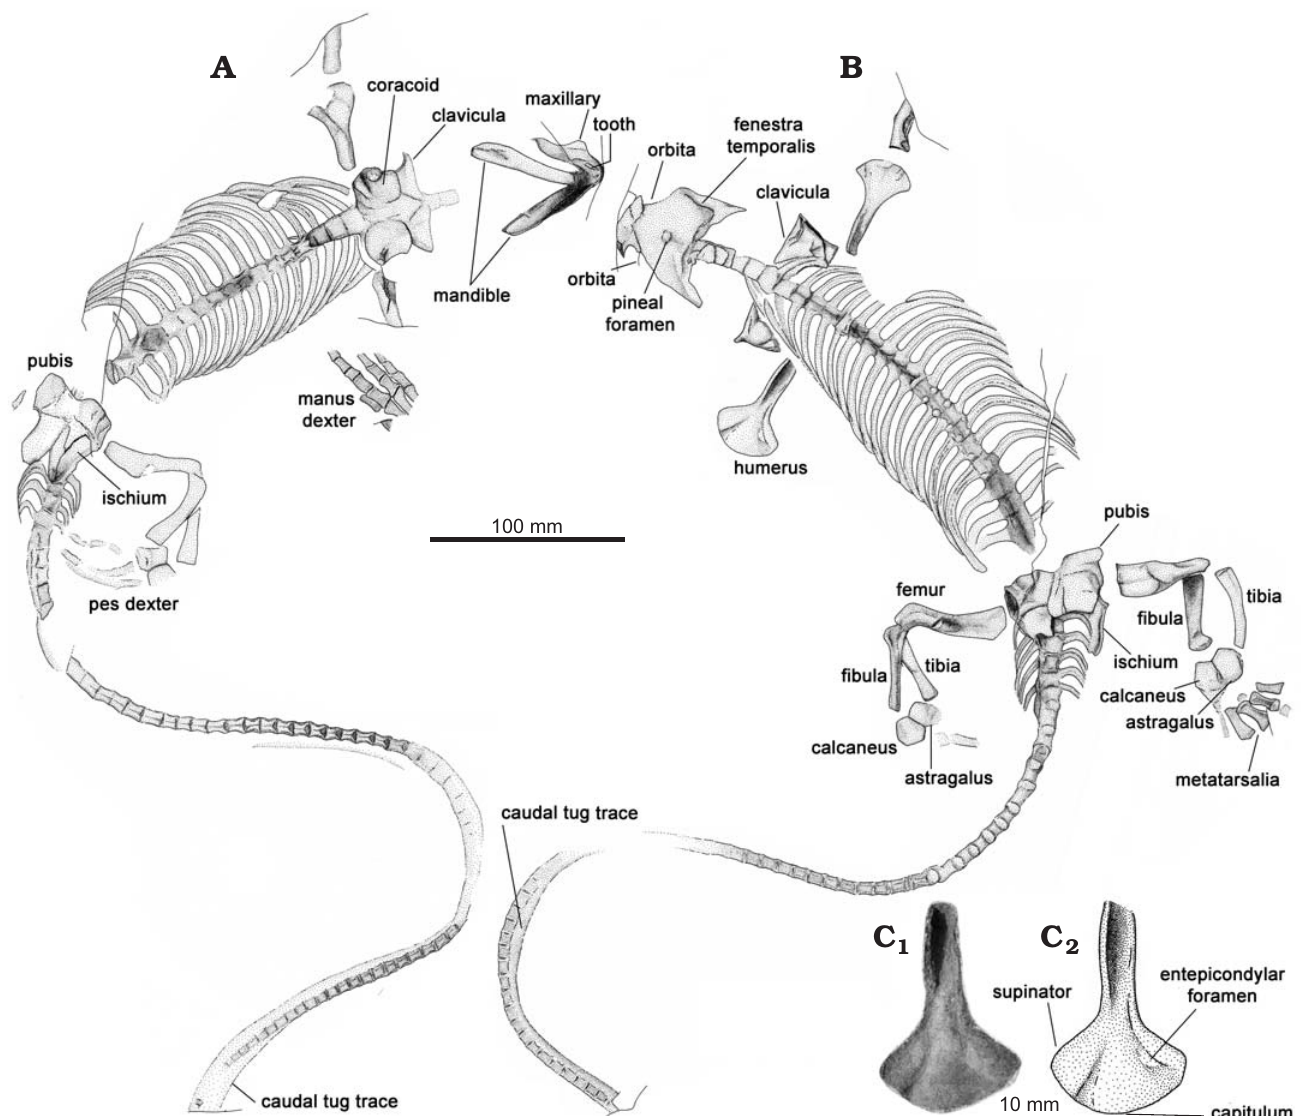
Fig. 4. Explanatory drawing of the holotype of caseasaurian synapsid Datheosaurus macrourus Schroeder, 1904 from Upper Pennsylvanian of Nowa Ruda, Poland. MB.R. 1015.1 ( A ) and MB.R. 1015.2 ( B ). C . Right humerus of MB.R. 1015.2 in ventral aspect, photograph (C 1 ), drawing (C 2